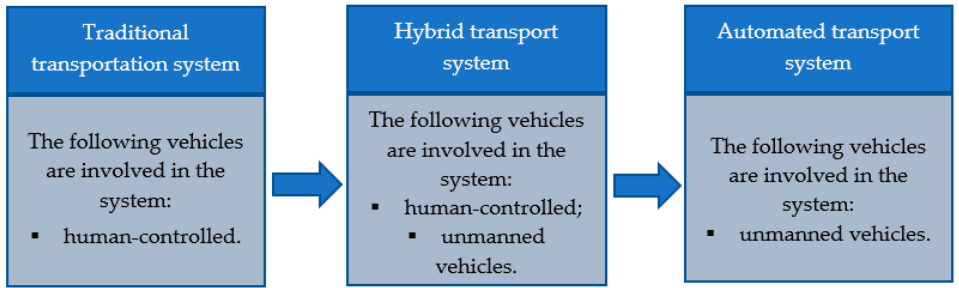
Figure 1. Algorithm for transforming a traditional transport system into an automated